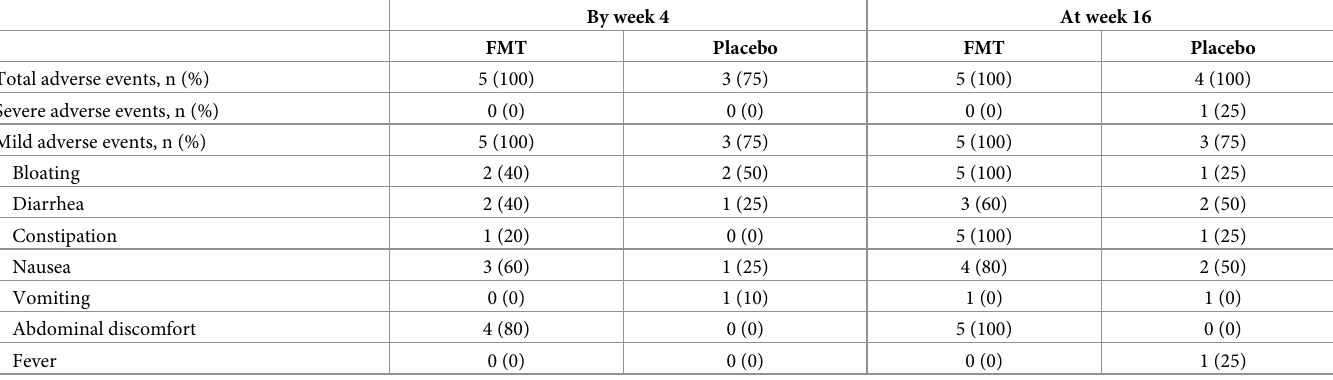
Table 2. Cumulative incidence of adverse events by week 4 and week 16 in the ReSScue pilot